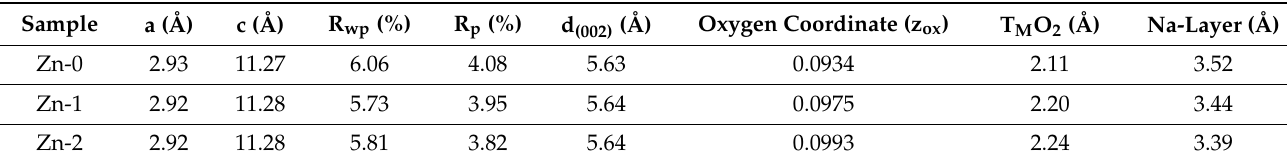
Figure 4. Rietveld refinement was performed on the XRD pattern of P2-type Na 0.60 Fe 0.5 Mn 0.5 − x Zn x O 2 ( a ) x = 0 (Zn-0) ( b ) 0.01 (Zn-1) and ( c ) 0.02 (Zn-2) cathode powder using Rigaku software. Observed data is represented as red circles, calculated Rietveld data model as a black line, the difference between the data and model is shown with magenta color and Bragg position is shown using a vertical reflection marker. All Rietveld fit data has R wp and R p values below 10%. ( d ) Graphical representation of the lattice parameter a and c observed after Rietveld refinement on the XRD pattern of Zn-0, Zn-1 and Zn-2 cathodes sample. Table 1. Crystallographic refined lattice parameters and calculated TMO 2 /Na-layer thickness value for Zn-0, Zn-1 and Zn-2